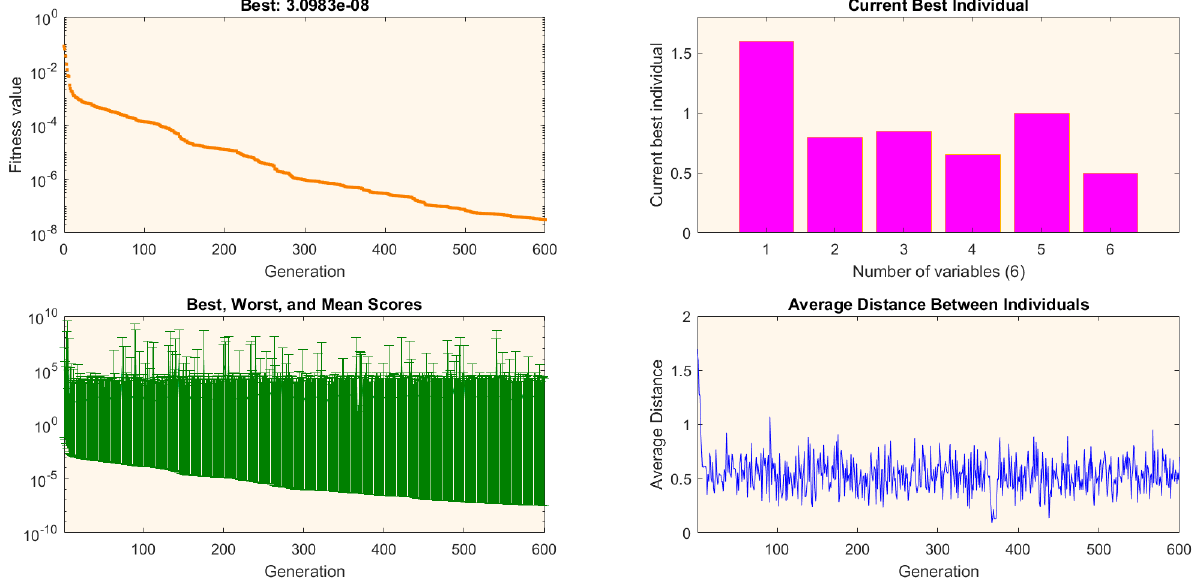
Figure 3. Results of Problem 1 in terms of learning curve, best individual scores, and average distance for no noise scenario.